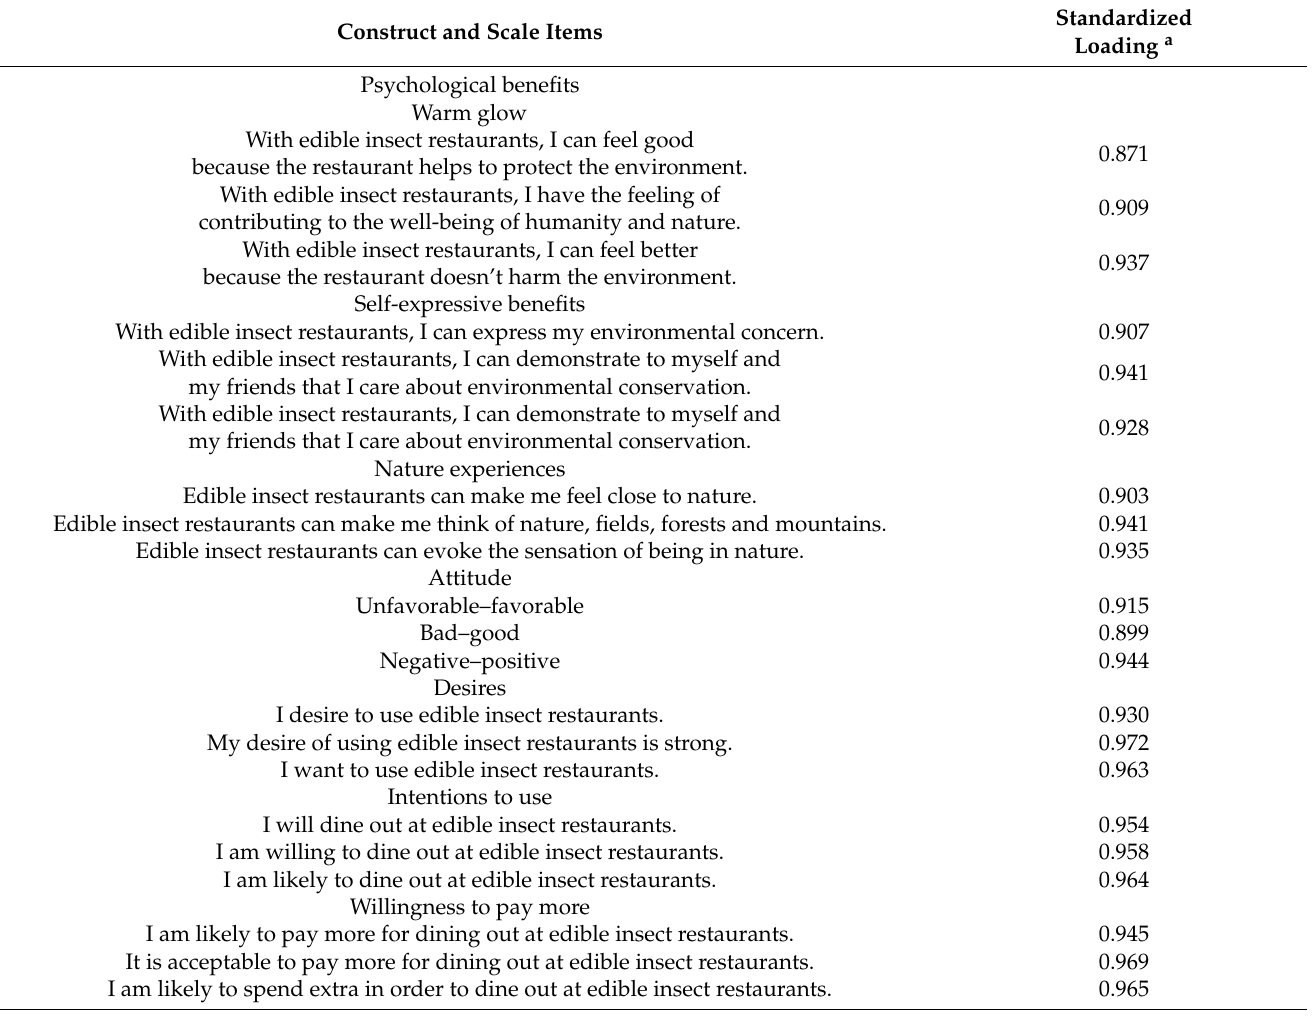
Table 2. Confirmatory factor analysis: items and loadings.